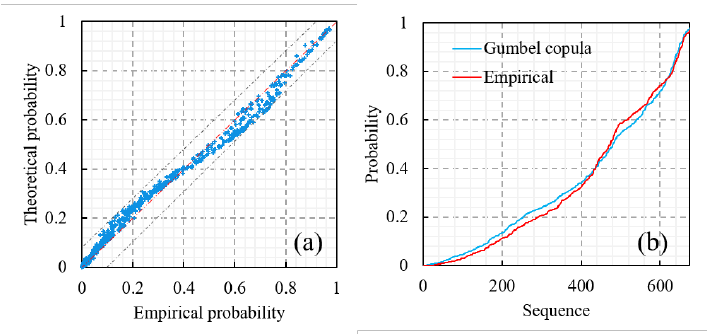
Figure 16. Comparison of theoretical and empirical probability with Gumbel copula: ( a ) Q-Q plots; ( b ) empirical and theoretical probabilities.